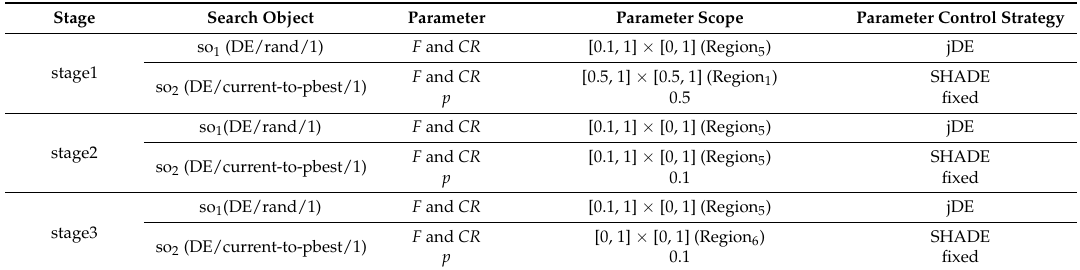
Table 3. The parameter scheme of